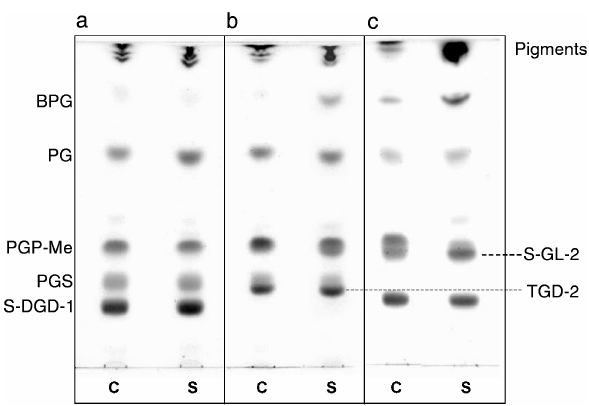
Figure 3. Effect of osmotic stress on the lipid profiles of (a) Halo- quadratum walsbyi , (b) Haloarcula marismortui and (c) Haloferax volcanii . Eighty µg of lipid extracts was loaded on each lane. Eluent: Solvent A. Lipids were detected by spraying with 5% sulfuric acid and charring at 120 °C. Abbreviations: C = whole cells (control); S = cells after hypotonic shock (shocked